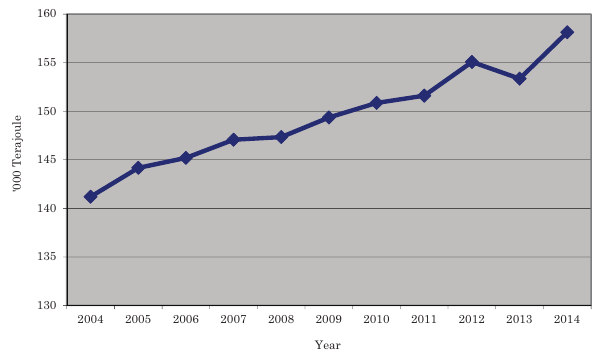
Fig. 1. Hong Kong’s total electricity consumption, 2004–2014 (Census and Statistics Department 2016)